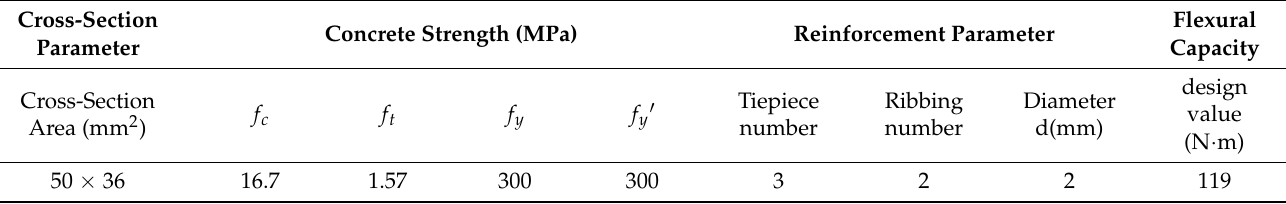
Table 3. Design parameters of anti-slide pile strength.